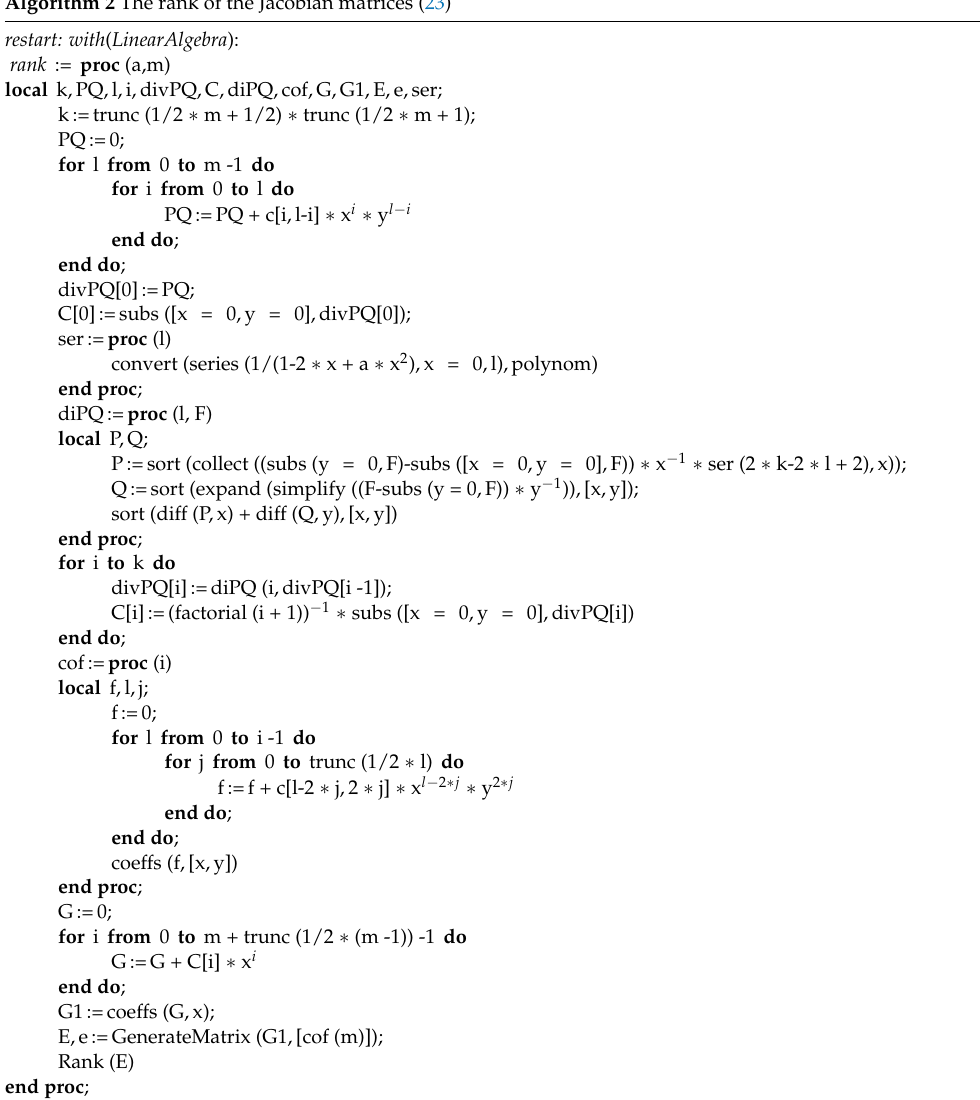
Algorithm 2 The rank of the Jacobian matrices